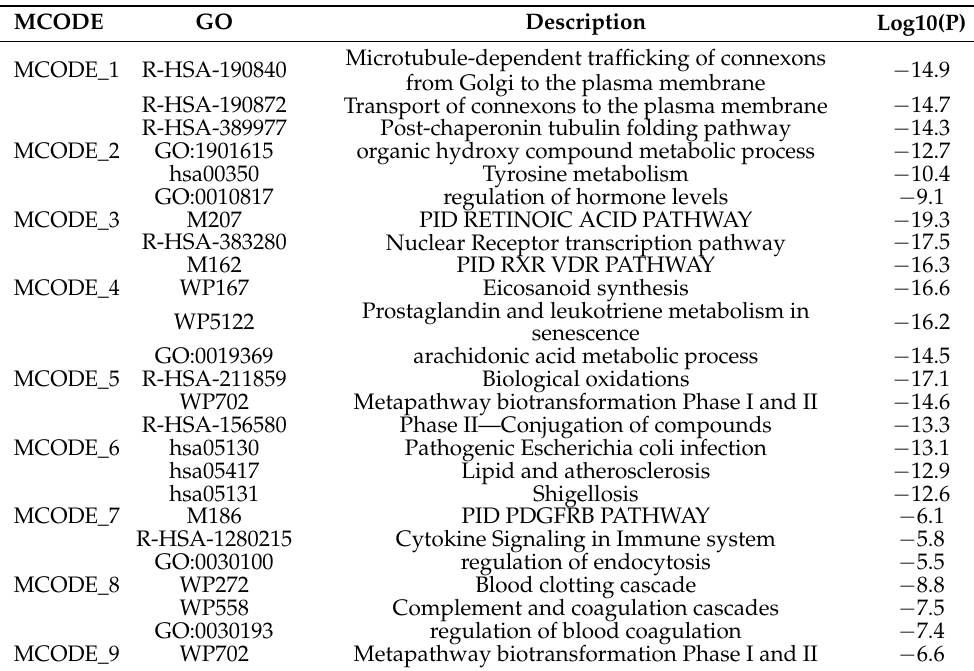
Figure 4. The potential pathways of FA/p-CA targets. ( A , B ) Protein–protein interaction network and MCODE components identified in FA targets. ( C , D ) Protein–protein interaction network and MCODE components identified in p-CA targets. Table 1. MCODE components identified in FA target